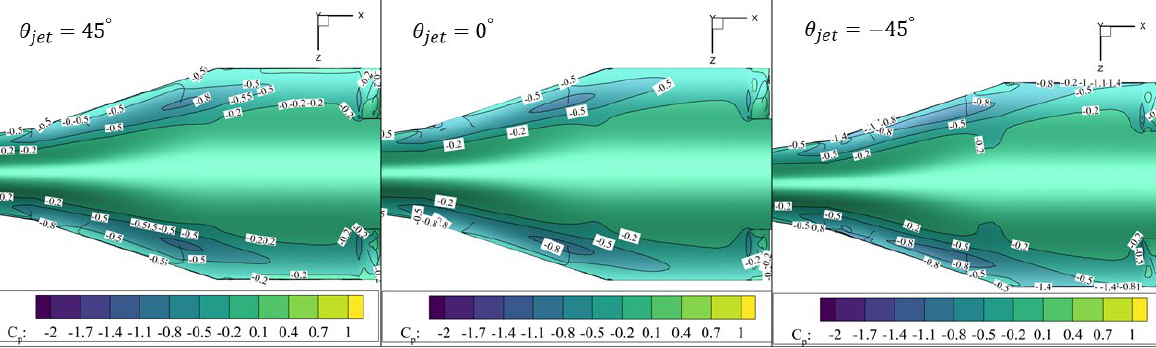
Figure 23. Comparison of the pressure coefficient distributions on the upper surfaces for different blowing directions at α = 10 ◦